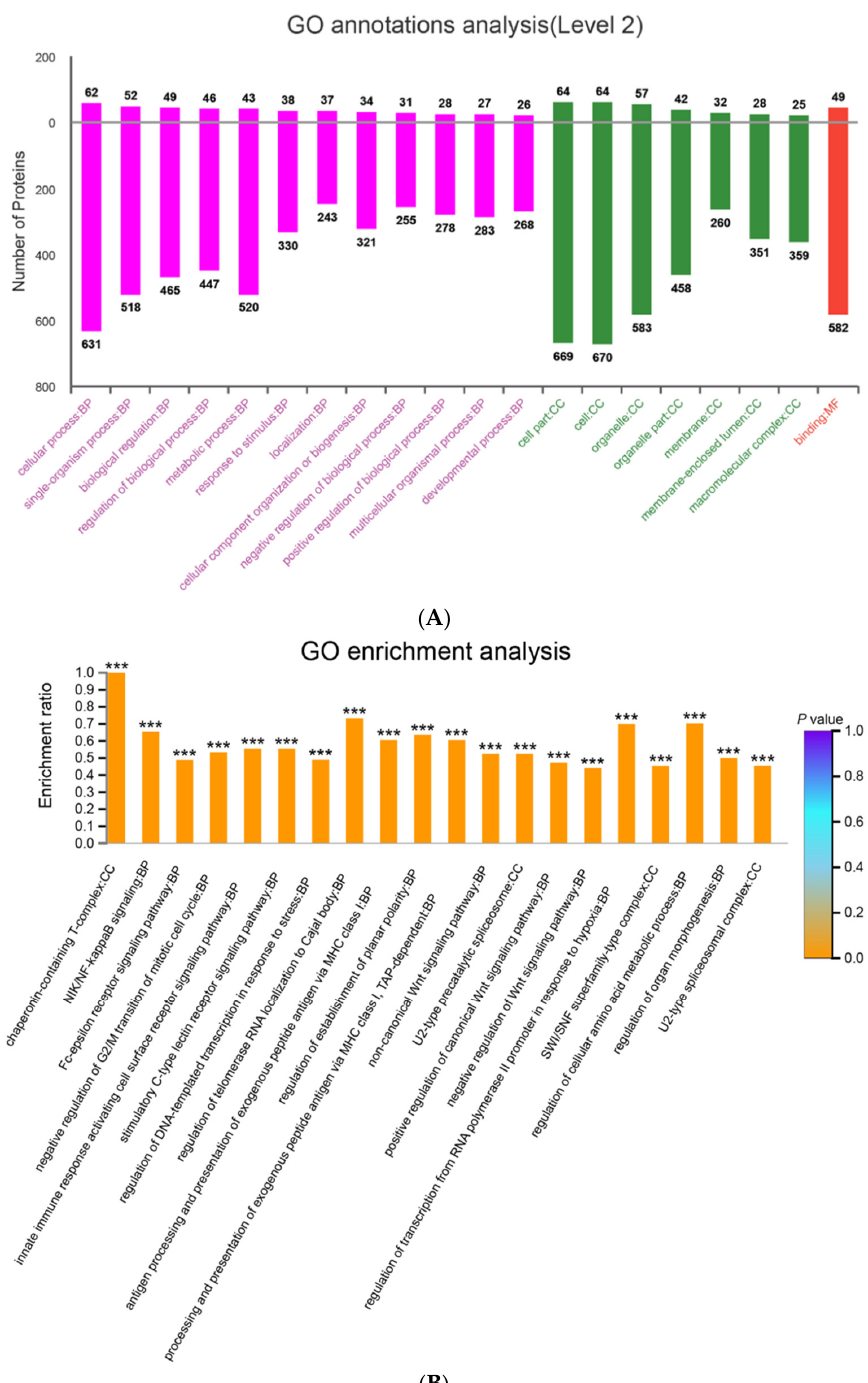
Figure 4. GO annotation and GO enrichment analysis of DEPs between mock- and PRV-infected Vero cells. ( A ) Up- and downregulated proteins are classified into three categories, respectively, by GO analysis: biological process (BP), cellular component (CC), and molecular function (MF). The x-axis represents the specific categories in BP, CC, and MF. The numbers on the y-axis indicate proteins in the category. ( B ) DEPs were subjected to GO enrichment analysis and the top 20 GO terms are listed on the x-axis. The y-axis indicates the enrichment ratio of DEPs and different colors represent different p values. *** indicates significance at a 99.9% confidence interval ( p < 0.001).